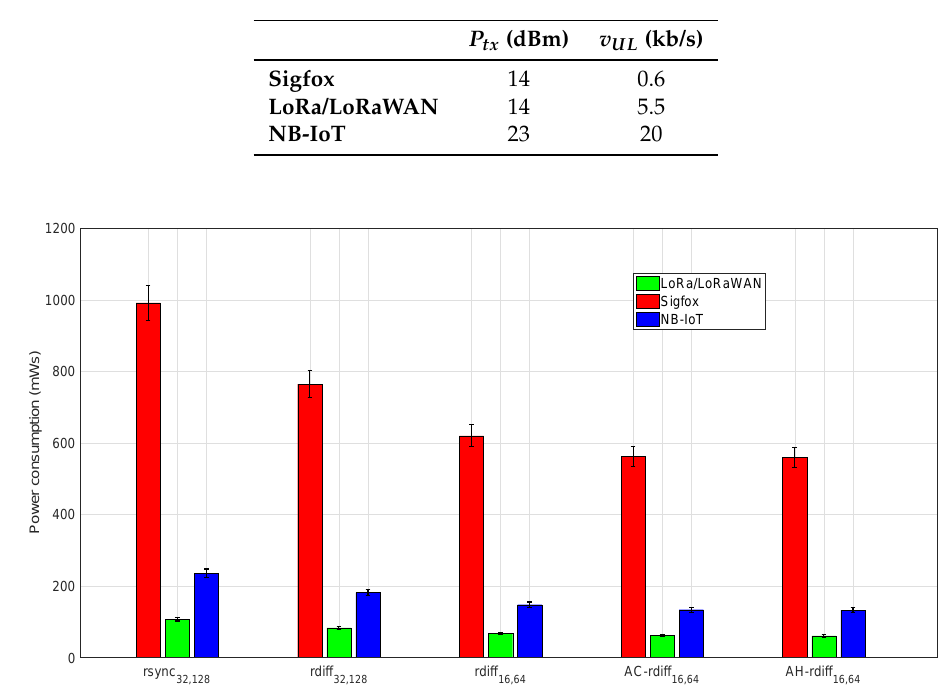
Table 3. LPWANs Technologies Parameters.